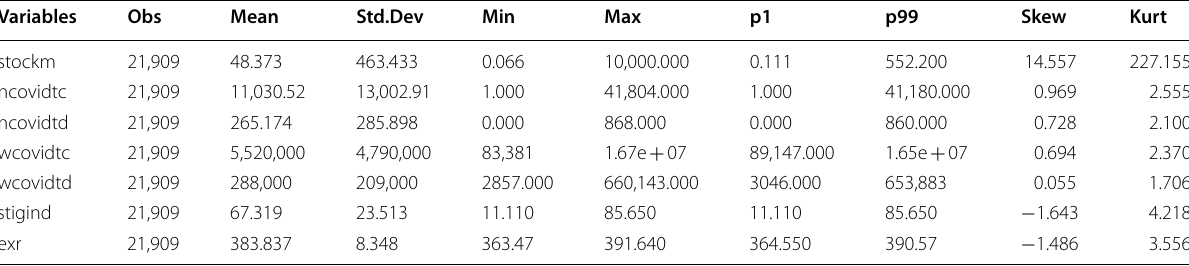
stockm, ncovidtc, ncovidtd, wcovidtc, wcovidtd, stigind and exr are share price of firms, number of the COVID-19 confirmed cases in Nigeria, number of COVID-19 confirmed deaths in Nigeria, number of the COVID-19 confirmed cases in the World, number of COVID-19 confirmed deaths in the World. stringency index (proxy for lockdown) and exchange rate, respectively